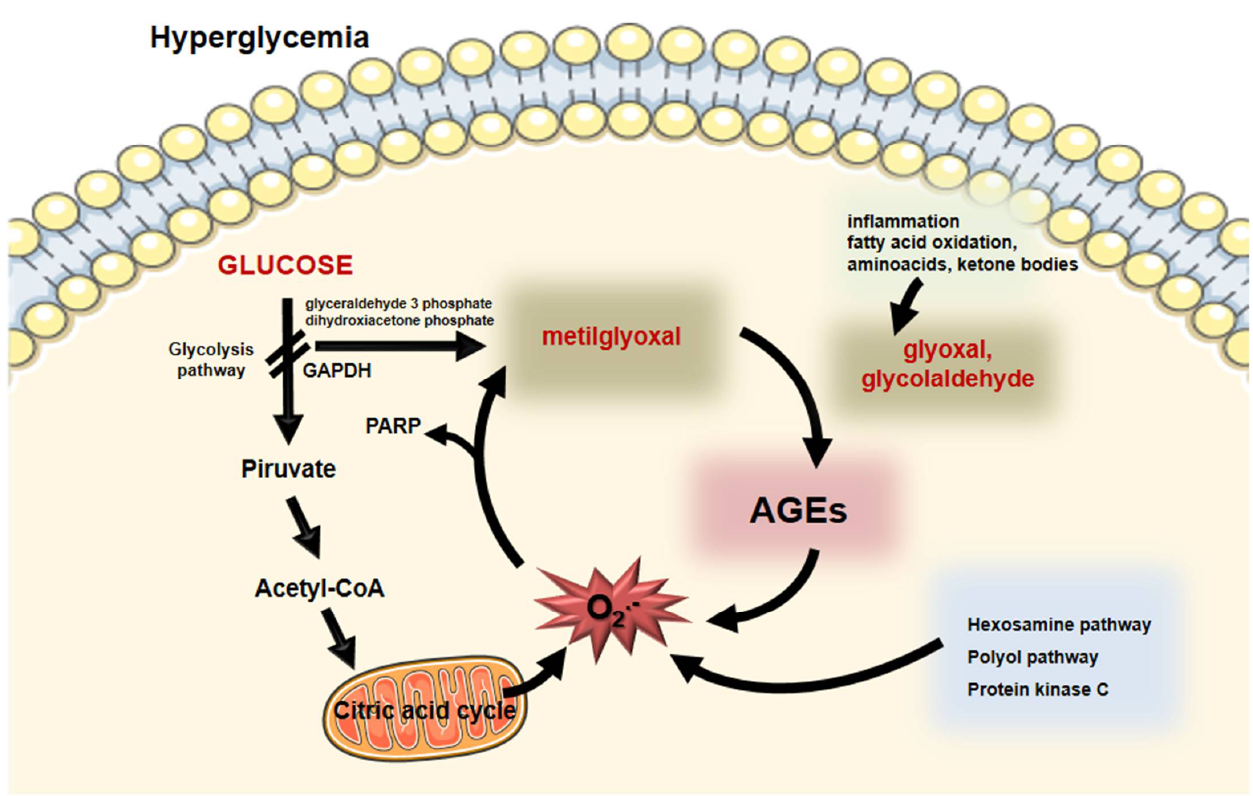
Figure 2. Intracellular formation of AGEs. During hyperglycemia, enhanced glucose flux through glycolysis induces the generation of superoxide anion by the mitochondria. Poly (ADP- ribose) polymerase (PARP) that protects DNA from cleavage induces a posttranslational modification of the glyceraldehyde 3P-dehydrogenase (GADPH) impairing glycolysis. Substrate (glyceraldehyde 3 phosphate and dihydroxyacetone phosphate) deviation leads to the generation of methylglyoxal that induces the formation of AGEs. Moreover, inflammation, fatty acid, amino acid, and ketone body oxidation generate oxoaldehydes, including glyoxal and glycolaldehyde that promote AGE generation. Oxidative stress increases by AGEs and by other biochemical pathways elicited by hyperglycemia (hexosamine, polyol, and protein kinase C). This vicious circle feeds the formation of AGEs and oxidative stress that is the base of cellular complications in diabetes mellitus. Parts of the figure were drawn using Servier Medical Art (https://smart.servier.com/, accessed on 14 December 2021).